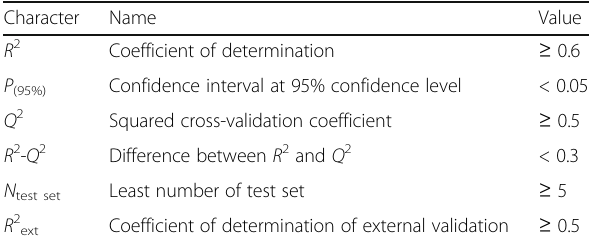
Table 2 Recommended values used in the assessing of